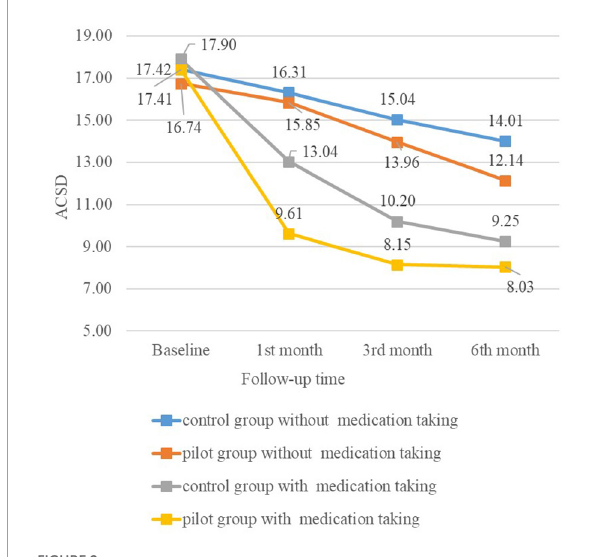
FIGURE2 Mean marginal estimates by medication-taking